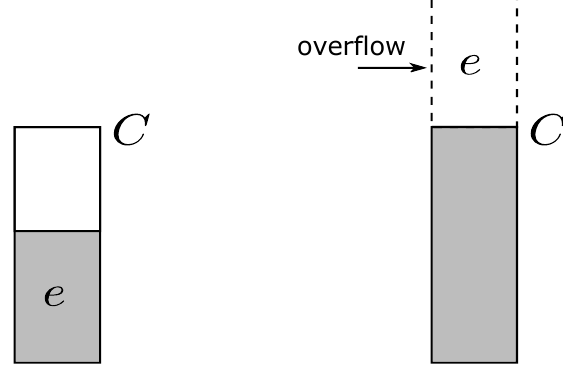
Figure 2. Illustration of energy overflowing.